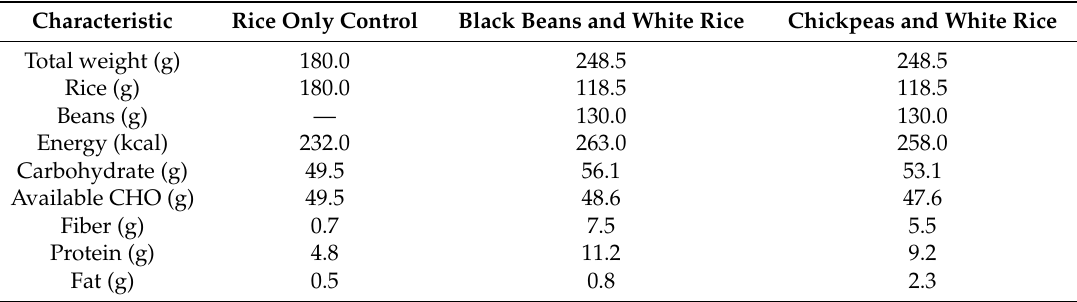
Table 1. Nutrient composition of test meals.